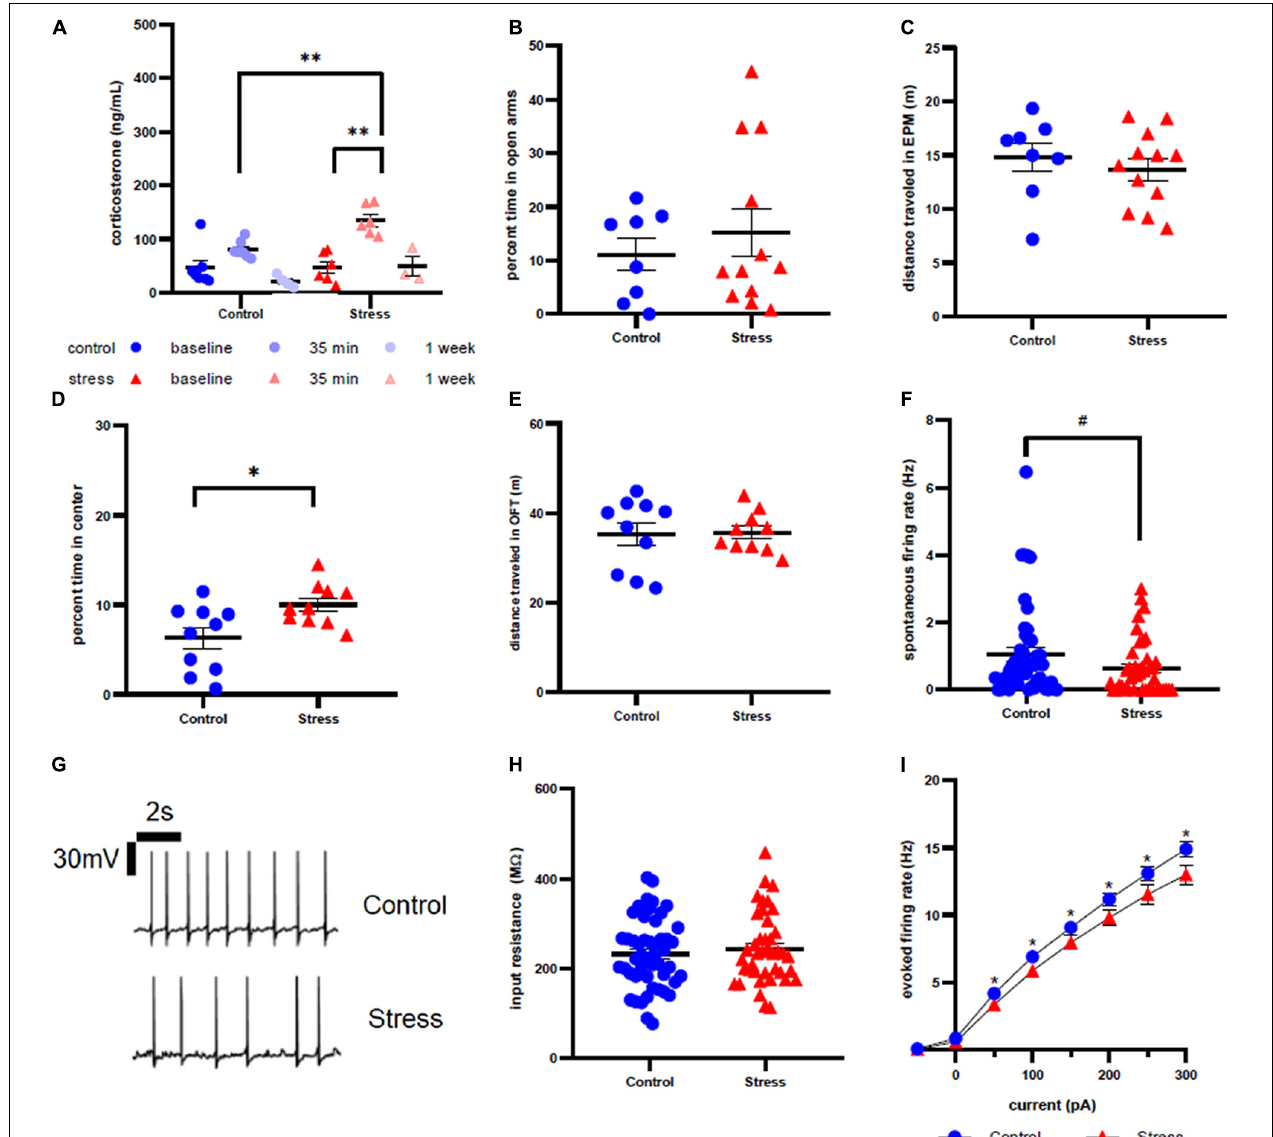
FIGURE 2 | Stress response in adolescent female rats. (A) Serum corticosterone concentration is higher 35 min after stress compared to baseline and to control at the same time point. (B) There is no effect of stress on time spent in open arms of the elevated plus maze immediately after stress or control conditions. (C) There is no effect of stress on distance traveled in the EPM. (D) Animals spend more time in the center of the open field test one week after stress compared to control. (E) There is no effect of stress on distance traveled in the OFT one week after stress. (F) There is no effect of stress on spontaneous firing rate of LC neurons one week after stress. (G) Representative traces for spontaneous firing in control (top) and stress (bottom) groups. (H) There is no effect of stress on input resistance of LC neurons one week after stress. (I) Stress decreases the excitability of LC neurons one week after stress. # p < 0.1; ∗ p < 0.05; ∗∗ p < 0.01.